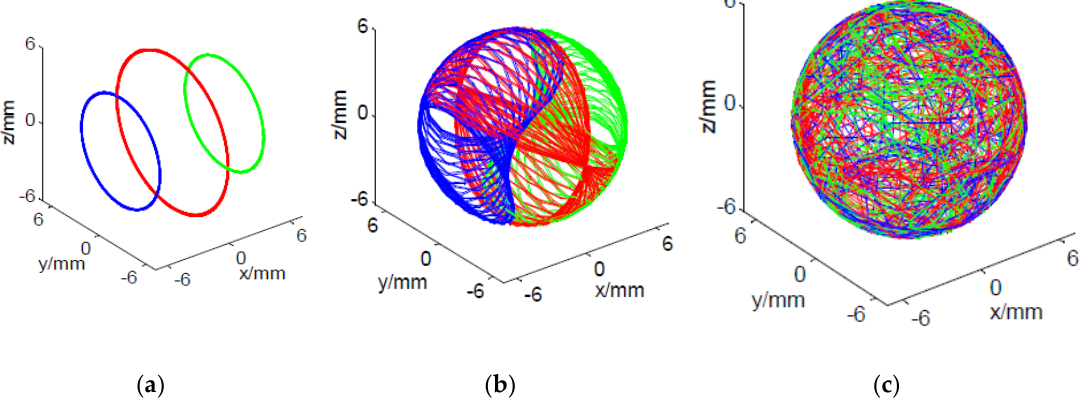
Figure 8. Traces of Contact points in di ff erent finishing methods ( a ) centric V-groove finish ( b ) eccentric V-groove finish ( c ) CMRF.